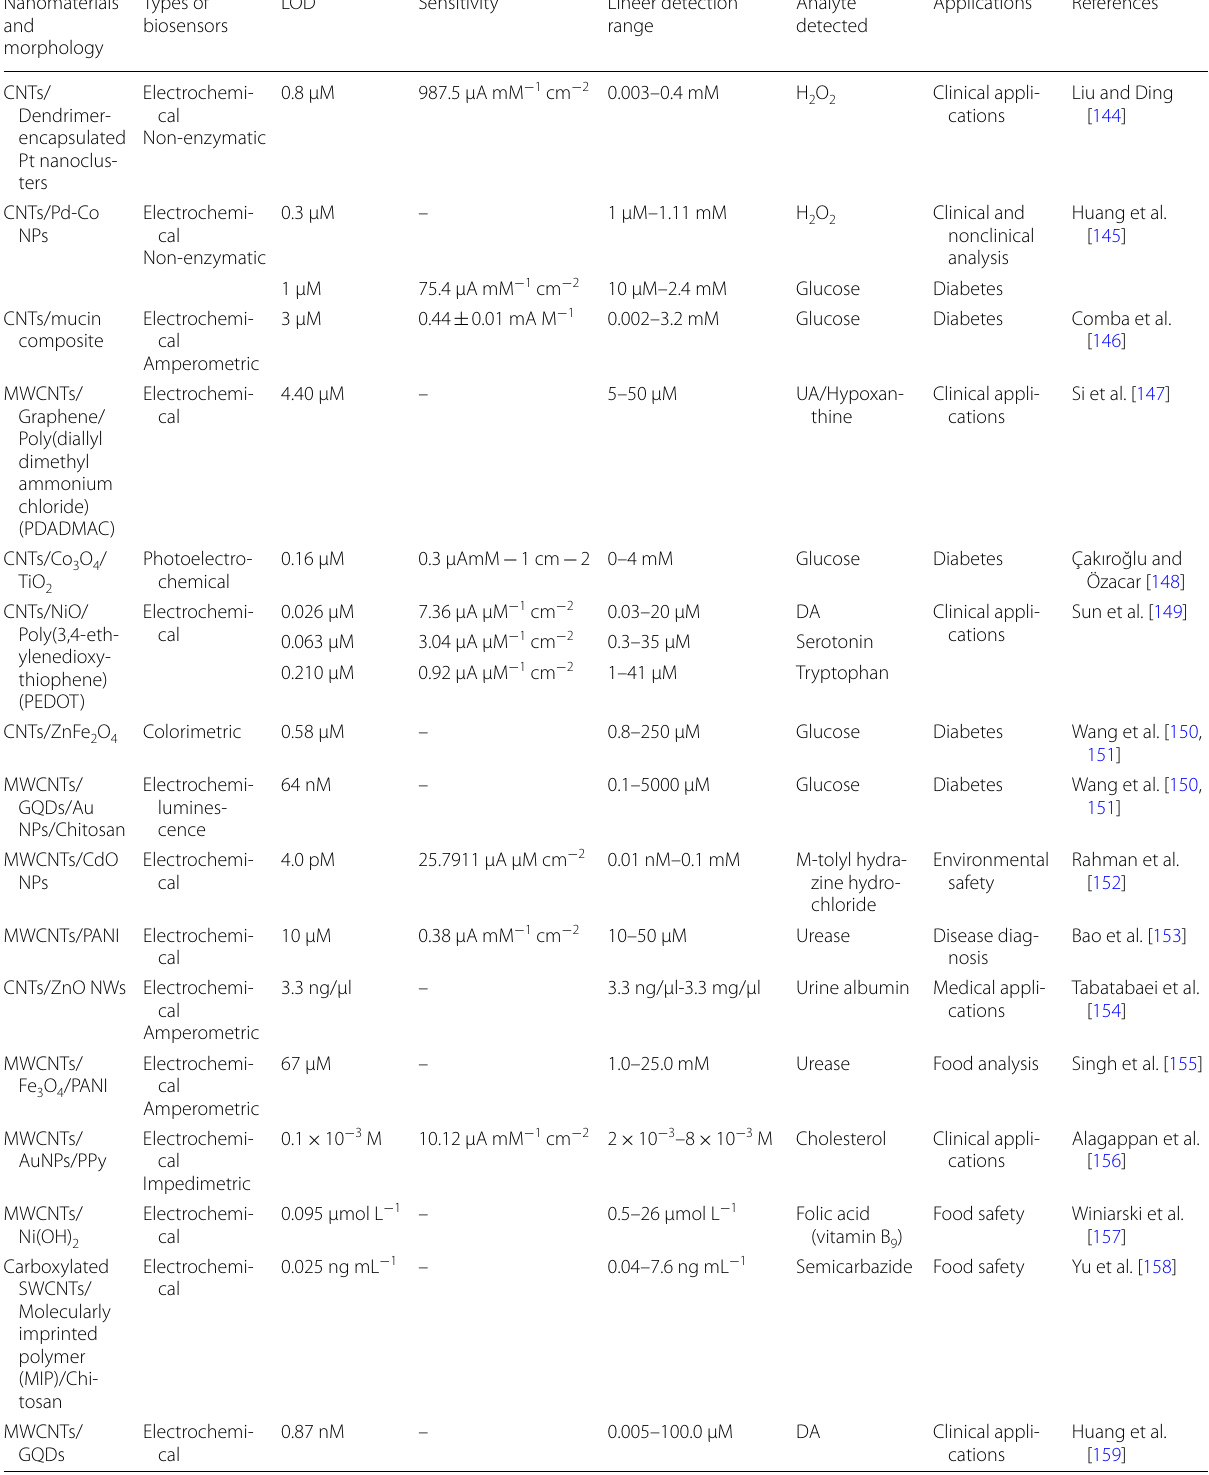
Table 4 Selected recent biosensor studies based on CNTs Nanomaterials and